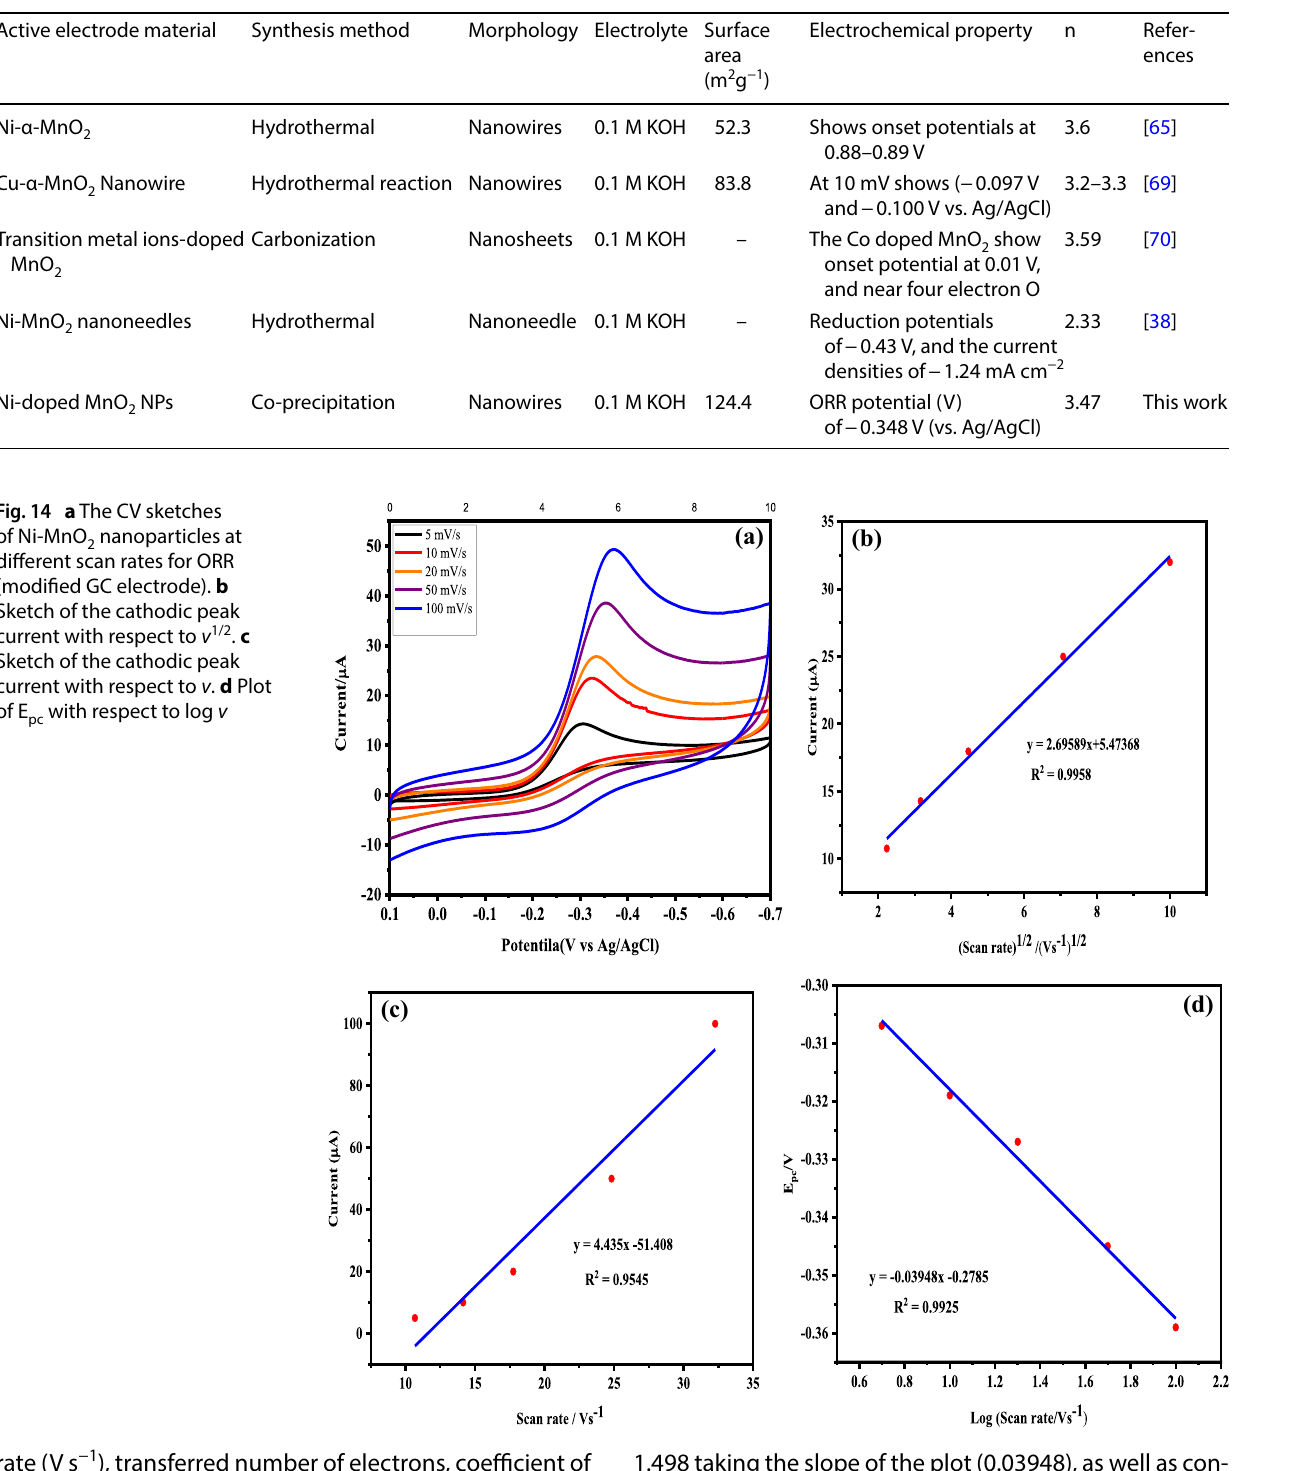
based electrocatalysts for ORR 2